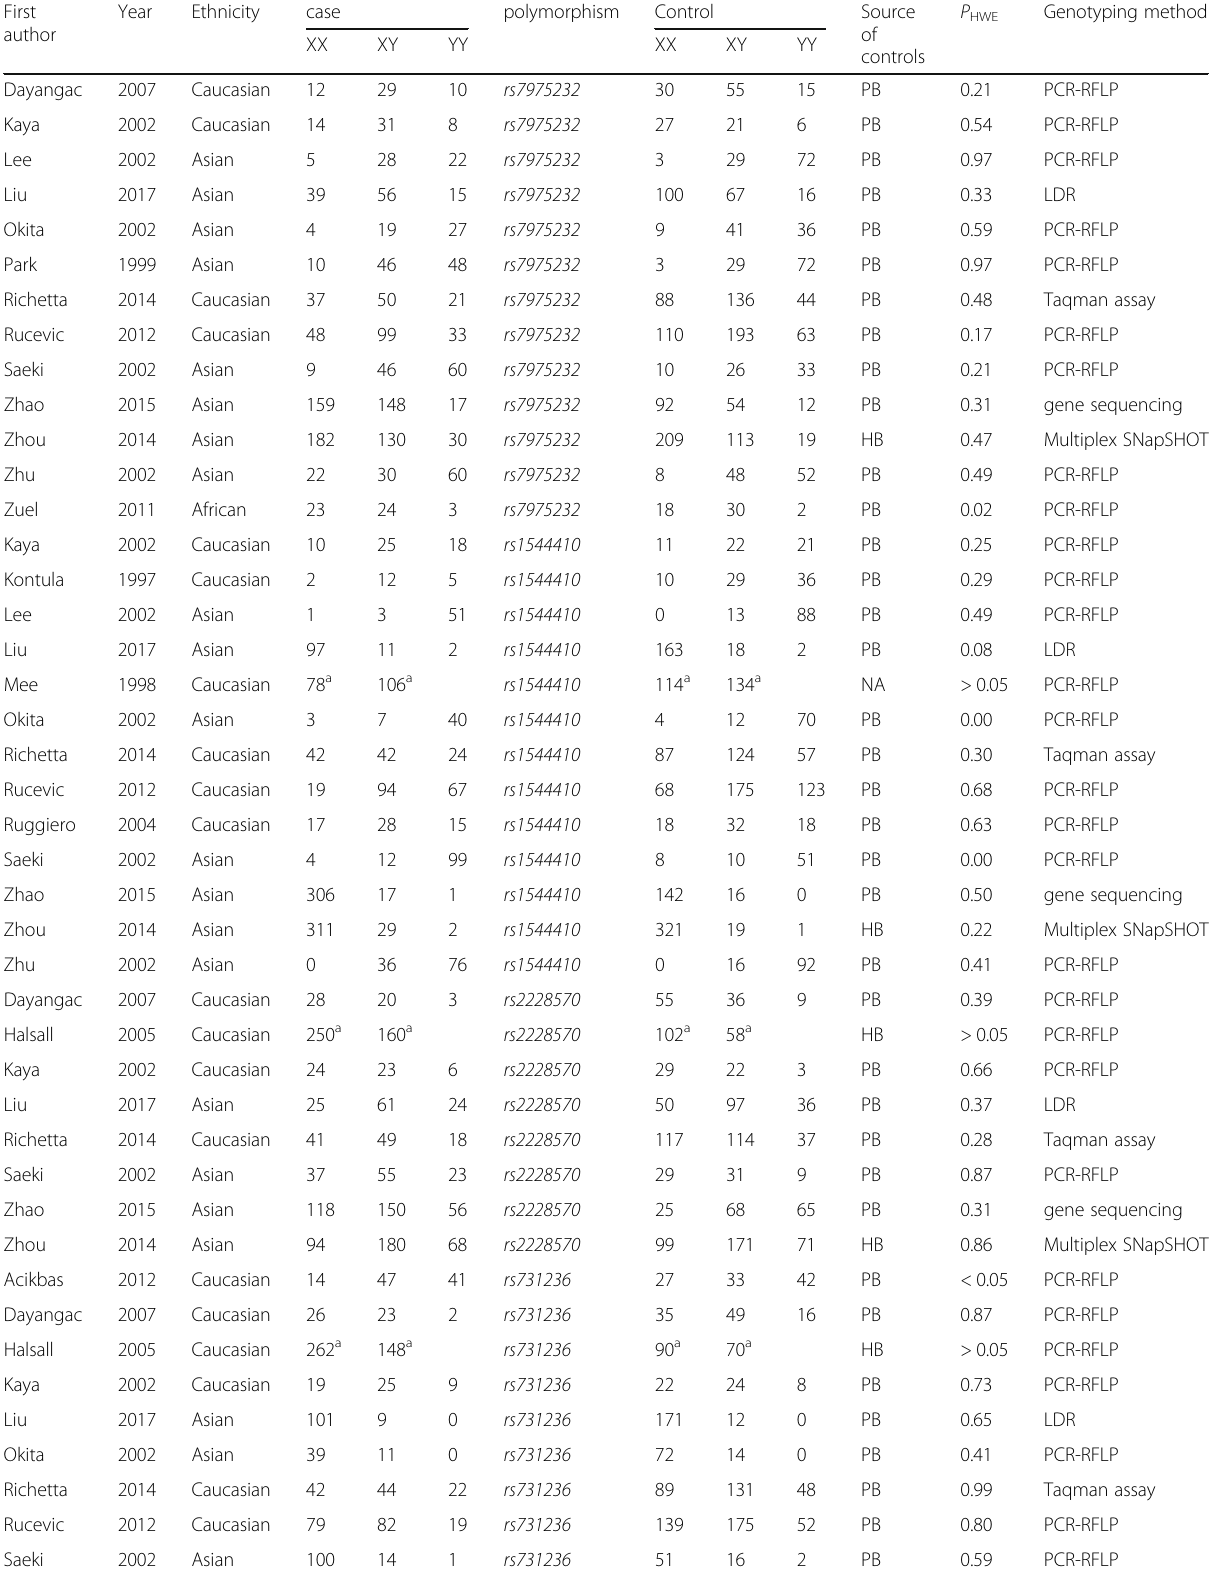
Table 1 Genotype distributions of included case-control